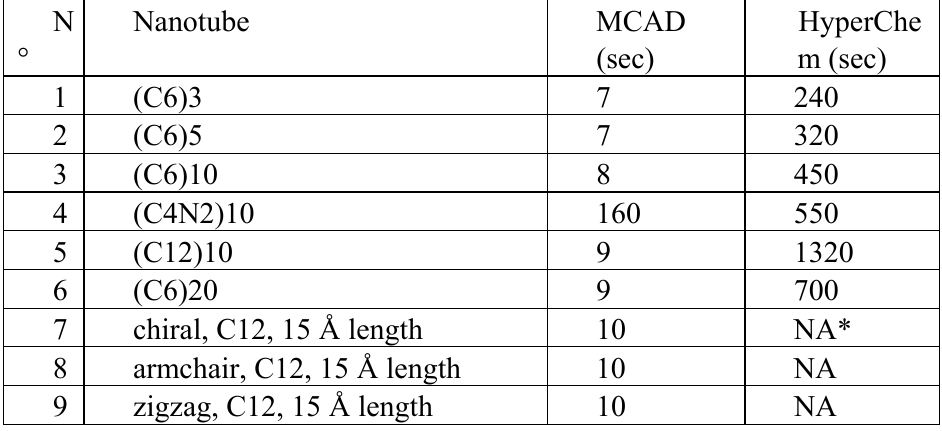
Table 1 . Nanotube generation MCAD performance, and its comparison with